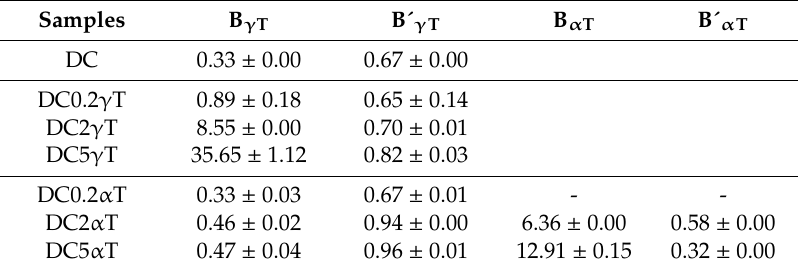
Table 4. Bioaccessibility of gamma- tocopherol ( γ T) and alpha -tocopherol ( α T) in the digestates of the di ff erent samples, in which these compounds are present, expressed in two di ff erent ways. B T = (mmol T D / mol (AF + GA) D ) and B’ T = (mmol T D / mmol T O ). Values are the average of two determinations, together with their standard